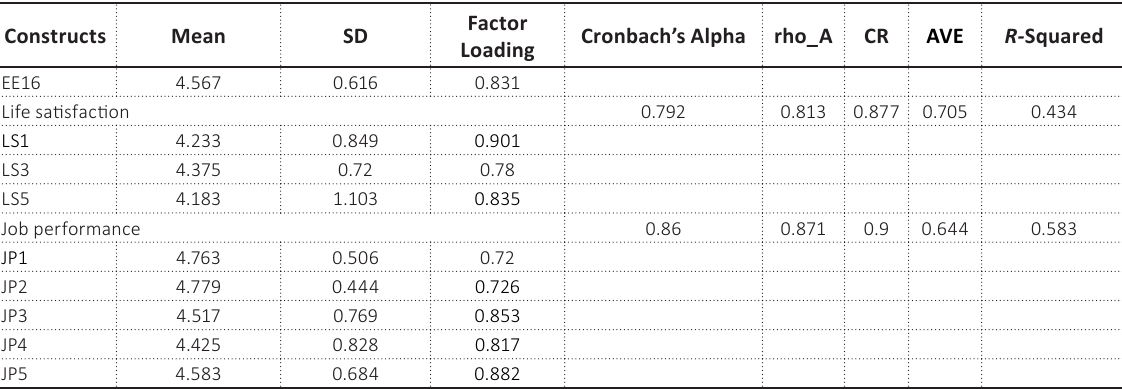
Table A1 (cont.). Reliability and convergent validity of the latent